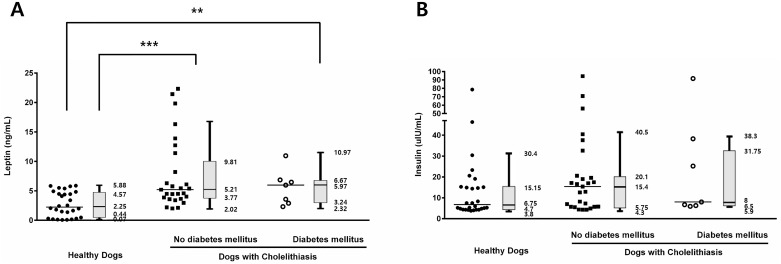
Serum leptin and insulin levels.The cholelithiasis group (n = 34) was divided according to the presence (n = 7) or absence (n = 27) of diabetes mellitus; the concurrence of diabetes with cholelithiasis had no significant effect on serum (A) leptin or (B) insulin levels. Horizontal bars in scatter plots indicate median values. **p < 0.01, ***p < 0.001 between groups.